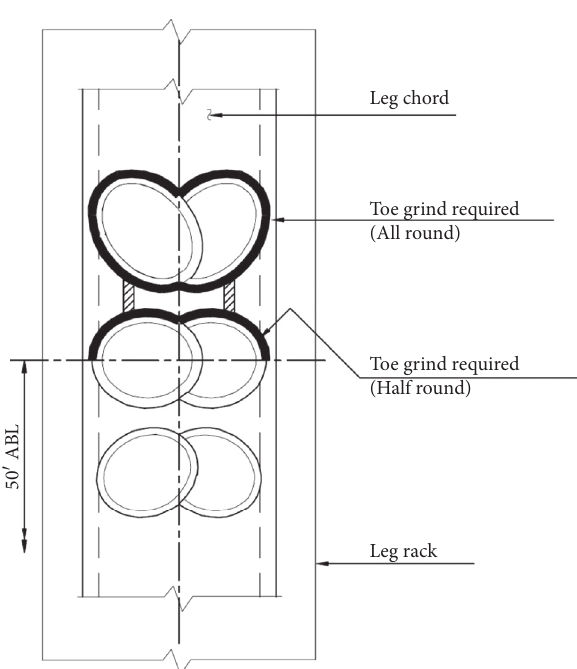
Figure 9: Recommended grinding of weld toe for the proposed